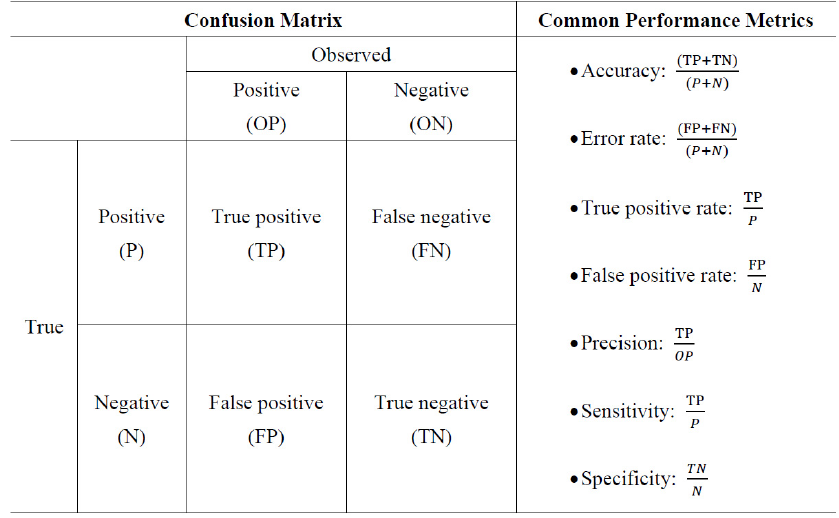
Figure 2. Confusion matrix and common performance metrics computed from it.